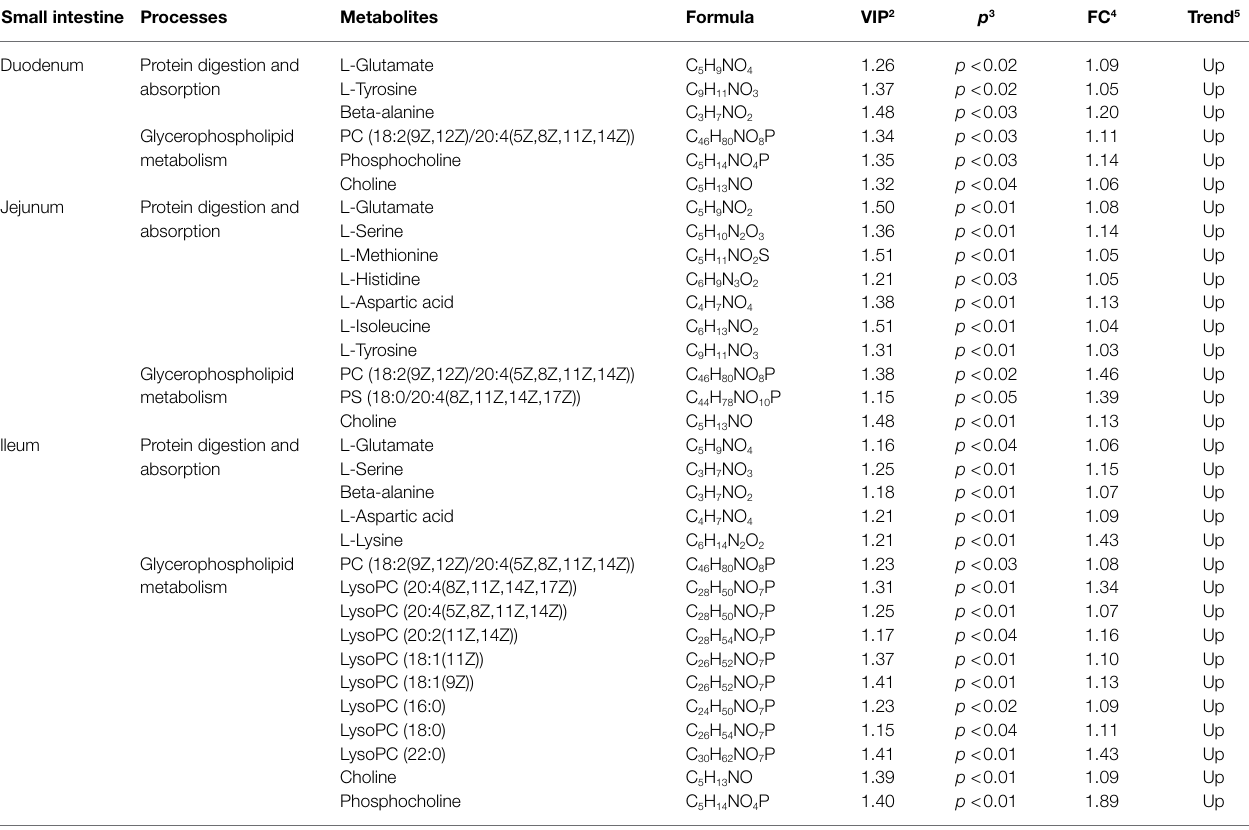
Small intestine Processes Metabolites